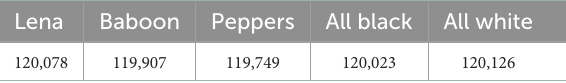
TABLE 7 Hamming distance (HD) between plain and cipher images.